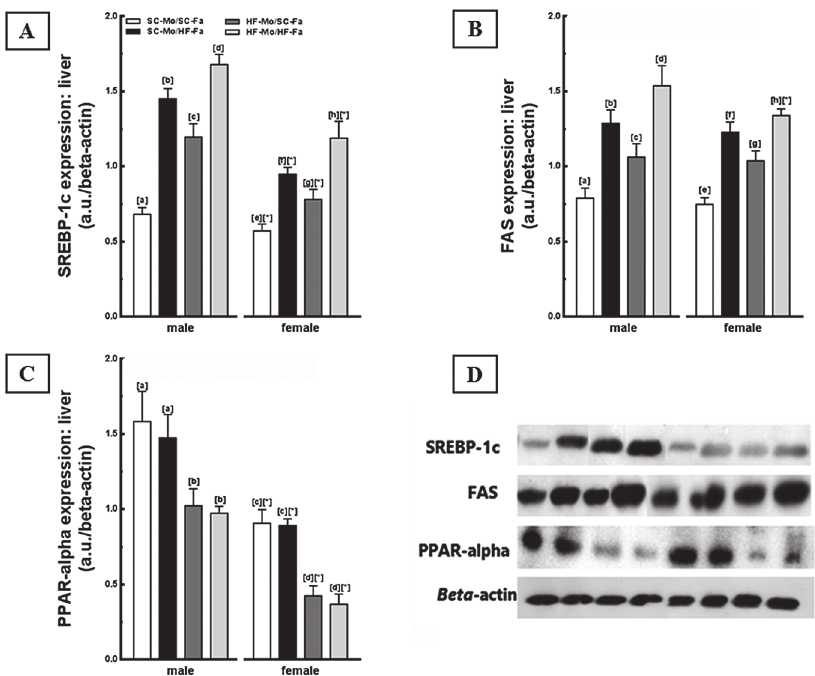
Fig 7. Molecular analyses in the offspring liver (panel 3). Liver immunoblotting corrected by beta-actin expression of the male and female offspring at 12-weeks old. (A) SREBP-1c, (B) FAS, (C) PPAR-alpha, and (D) representative immunoblotting with bands (expressed in arbitrary units, a. u.). Data are expressed as the mean and SD (N = 5 mice per group, one-way ANOVA and the posthoc test of Holm – Sidak). Same letters represent equal groups with no statistical difference while different letters represent different groups from each other, with statistical difference ( P < 0.05), * different from the corresponding counterpart ( P < 0.05). Abbreviations: sterol regulating element binding protein (SREBP-1c); fatty acid synthase (FAS); peroxisome proliferator activator receptor alpha (PPAR-alpha); offspring of SC mother and SC father (SC-Mo/SC-Fa); offspring of SC mother and HF father (SC-Mo/HF-Fa); offspring of HF mother and SC father (HF-Mo/SC-Fa); offspring of HF mother and HF father